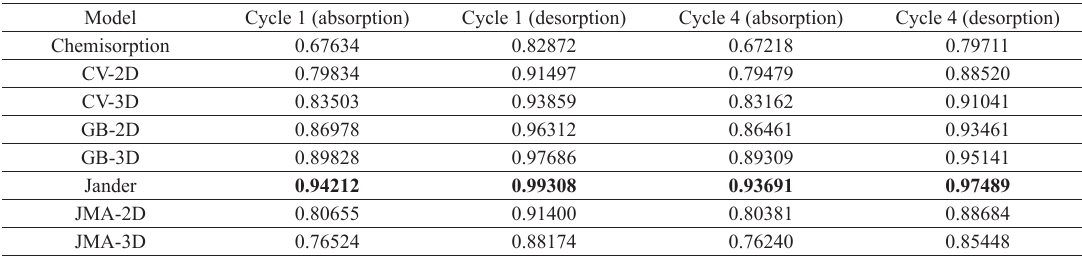
Table 2. Adjusted R 2 values for absorption and desorption rate-limiting step model regressions